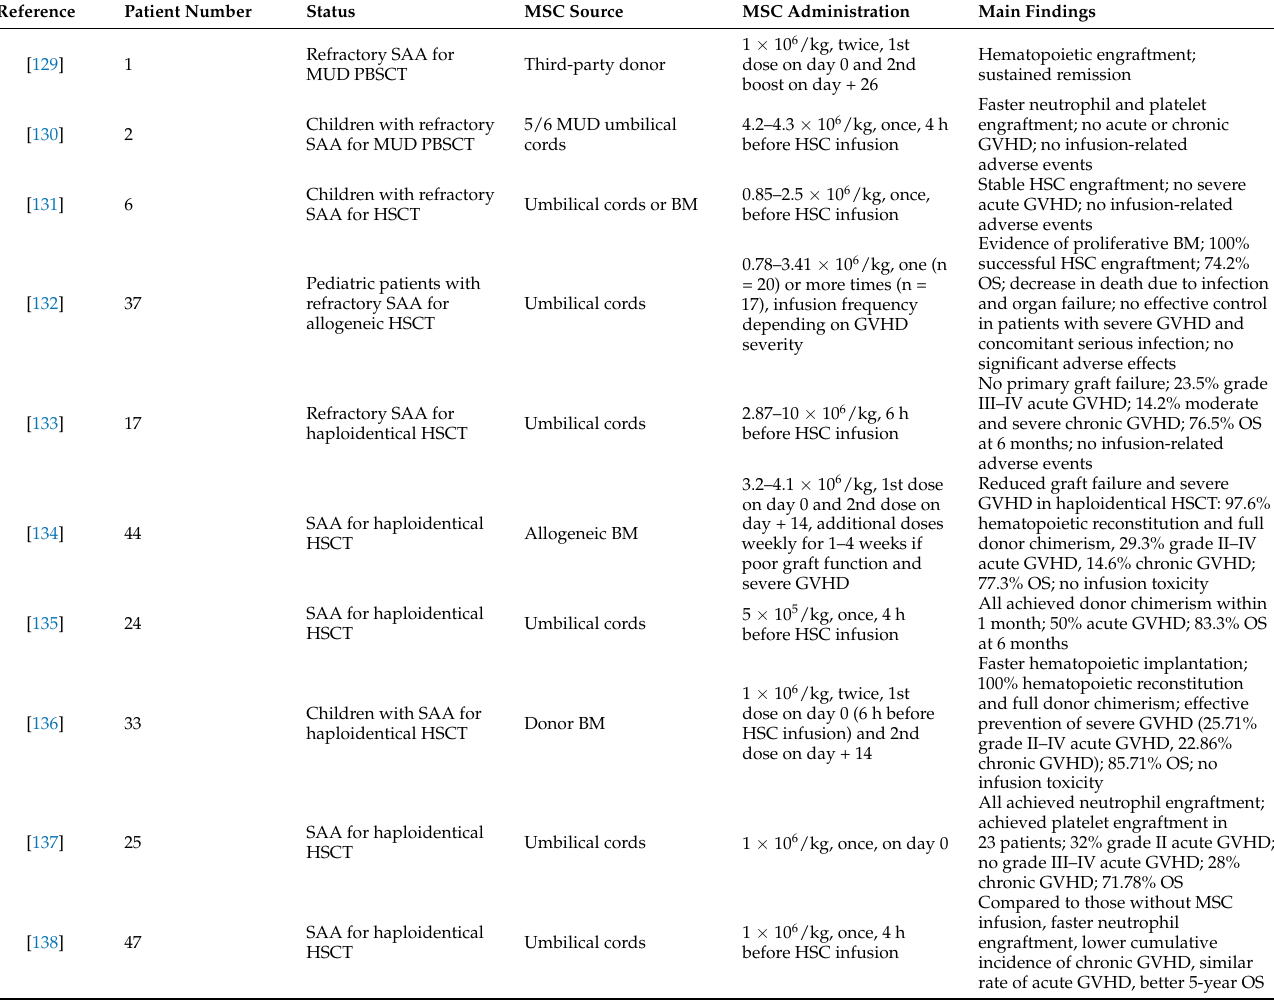
Table 3. Studies on co-transplantation of MSCs and HSCs for patients with